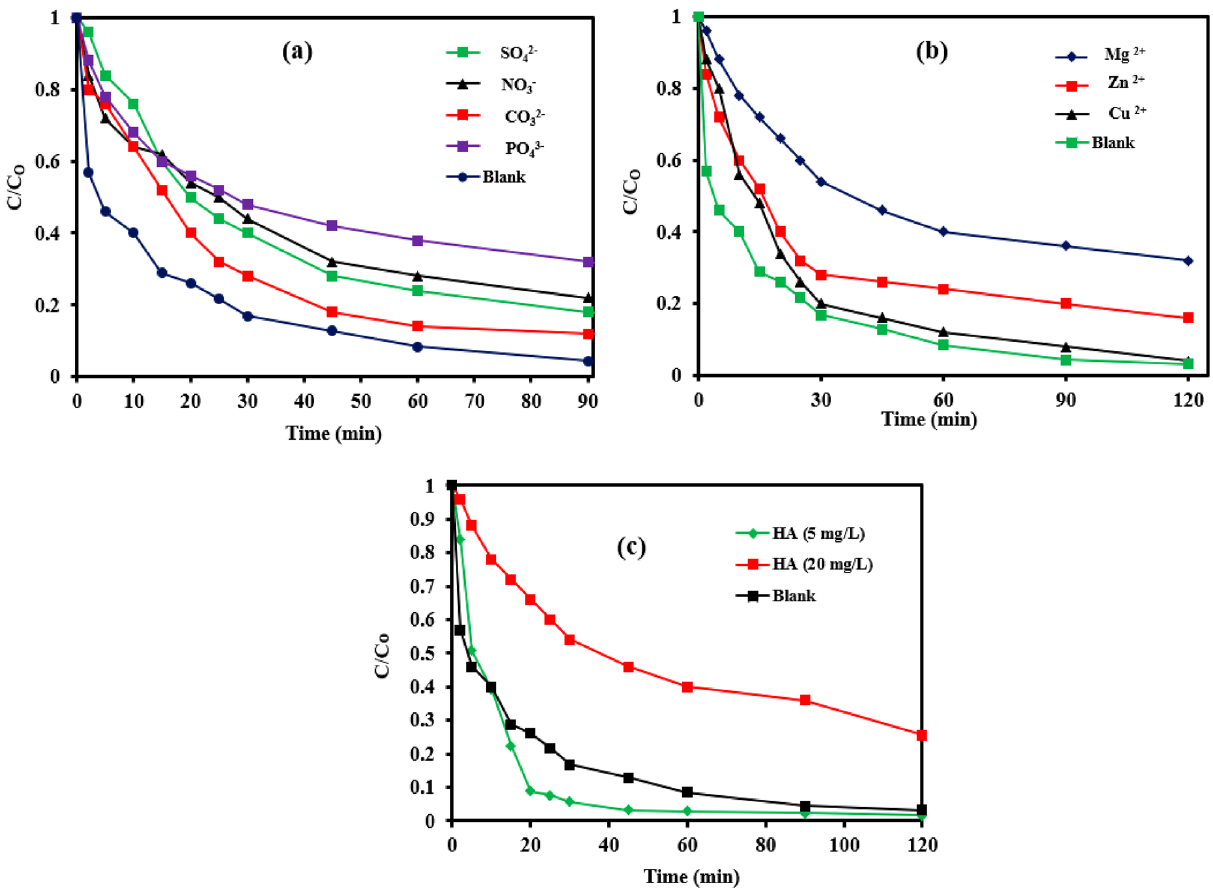
Figure 7. ( a ) Effect of co-existing ( a ) anions, ( b ) cations and ( c ) humic acid on the removal efficiency of Cr(VI) by